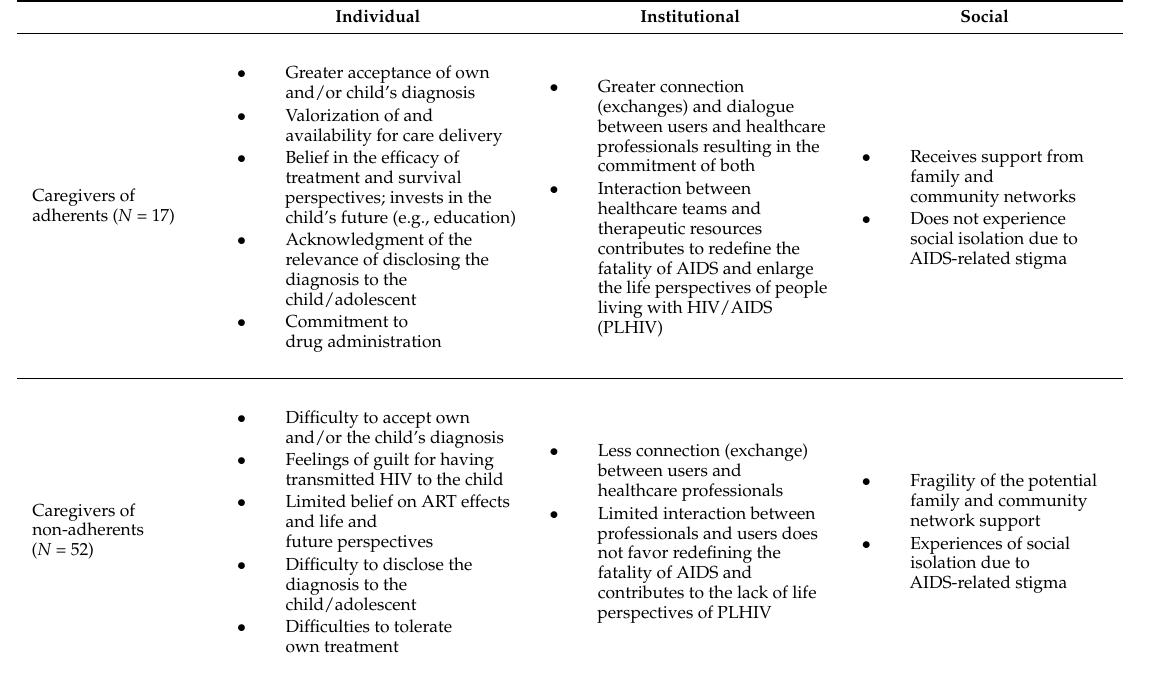
Table 2. Categories that differentiate caregivers of adherent and non-adherent CALHIV based on interviews with caregivers of CALHIV receiving antiretroviral treatment in five centers in different geographic regions of